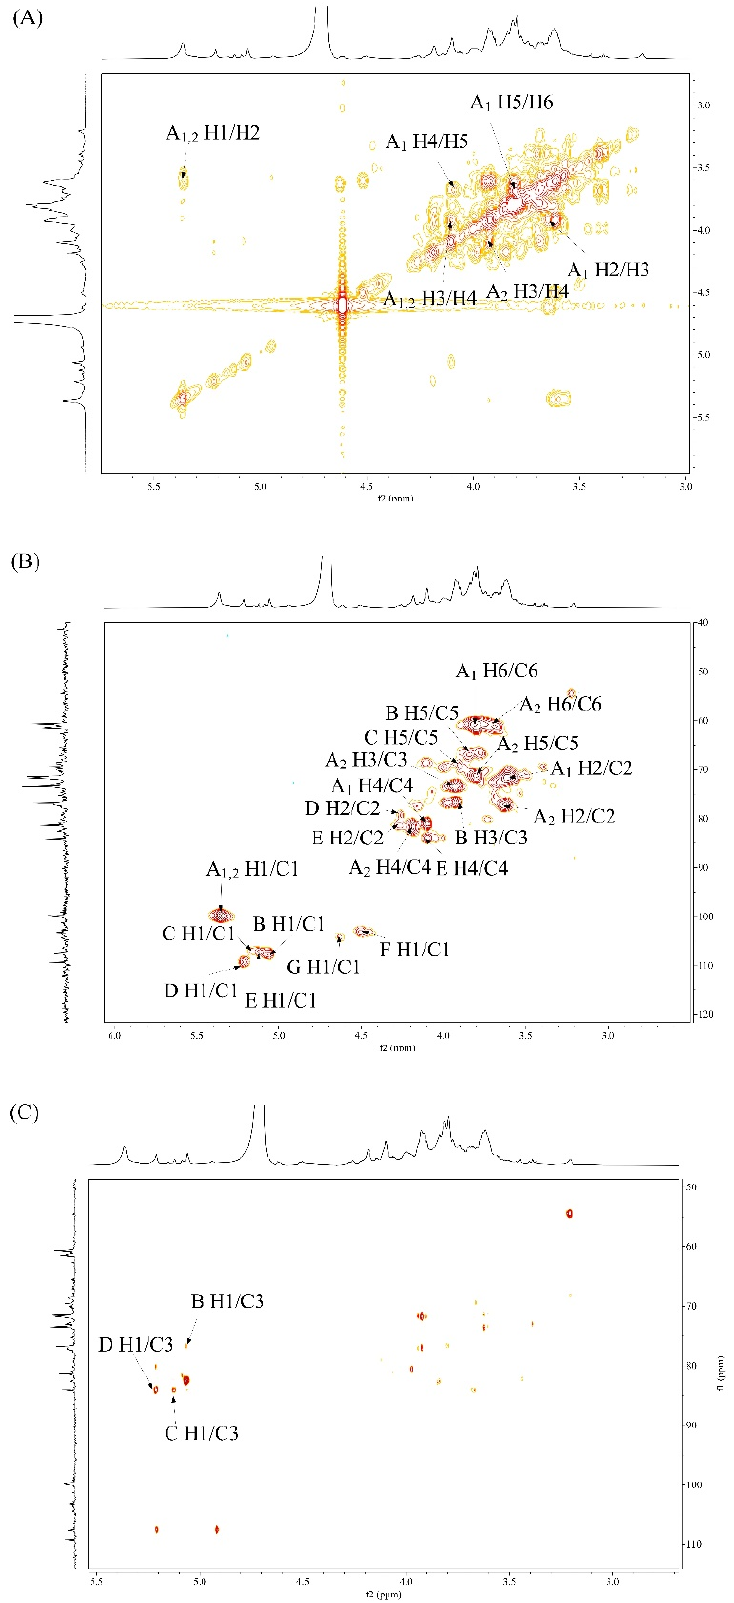
Figure 7. Two-dimensional NMR studies of JSP-1. ( A ) 1 H- 1 H COSY spectrum; ( B ) HSQC spectrum; ( C ) HMBC spectrum.